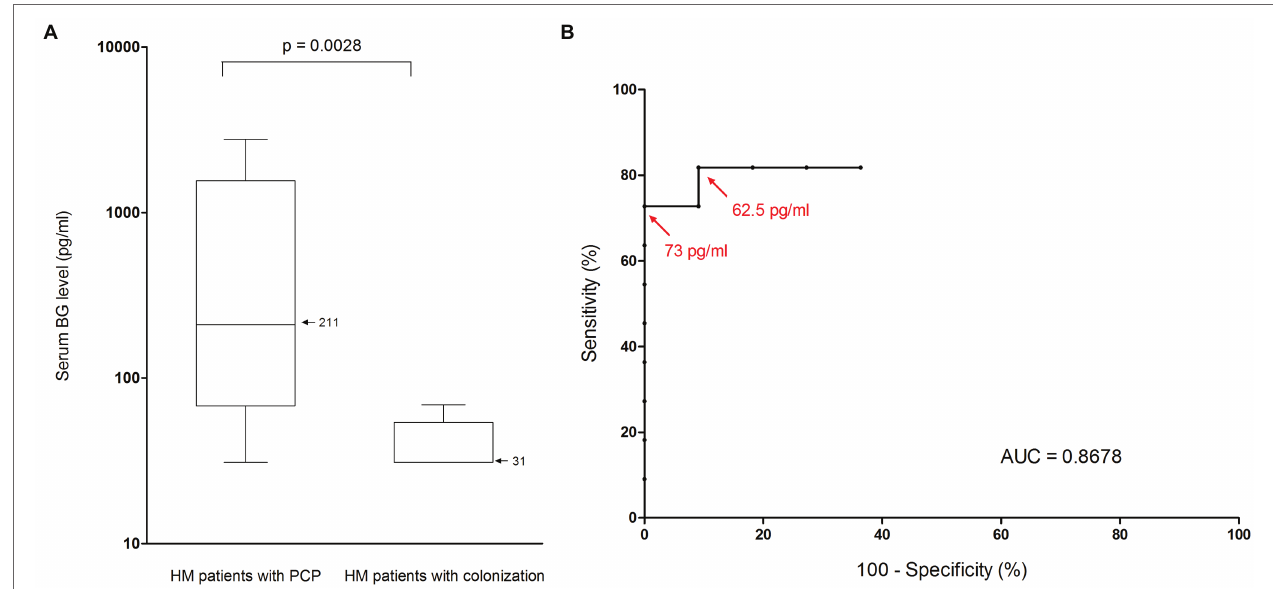
FIGURE 3 | Performance of BG assay for Pneumocystis pneumonia diagnosis in patients suffering from hematological malignancy. (A) Serum BG levels (pg/ml) in HM patients with Pneumocystis pneupneumonia and in HM patients colonized by Pneumocystis . Black horizontal bars, median values. The median value for HM patients with PCP was 211 pg/ml (range, 31–2,271; interquartile range, 1,489 pg/ml). The median value for HM patients with colonization was 31 pg/ml (range, 31–69; interquartile range, 23 pg/ml). Serum BG levels were significantly lower in the colonization group than in the PCP group (Mann–Whitney test, p = 0.0028). (B) Receiver operating characteristic curve for serum BG assay performance in HM patients, using microscopic detection of P. jirovecii as the reference method. Red arrows represent calculated thresholds for maximal specificity (73 pg/ml) and maximal sensitivity (62.5 pg/ml). AUC, area under the curve; BG, (1,3)- β -D-glucan; HM, hematological malignancy; and PCP, Pneumocystis